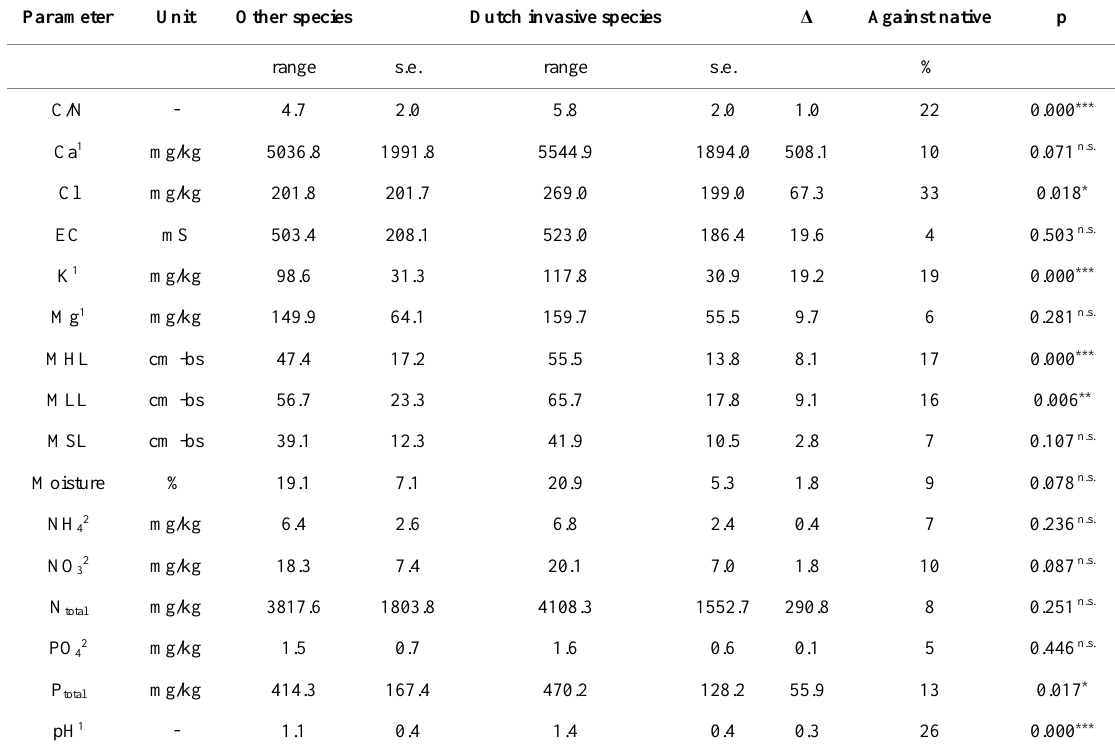
Table 2. Species ranges for abiotic soil parameters Dutch other species (without the neophytes and without the Dutch invasive species) and Dutch invasive species, including standard error, the difference between both groups and the p-values for the difference (two tail student t-test, n.s.; not significant, * p<0.05, ** p<0.01, *** p<0.001). Results per species are given in Appendix 3 for Dutch invasive species and Appendix 4 for the ‘Dutch other species’. With EC: